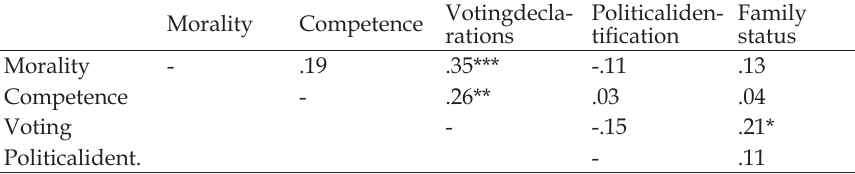
Table 1. Intercorrelations of Variables in Experiment 1. Morality Competence